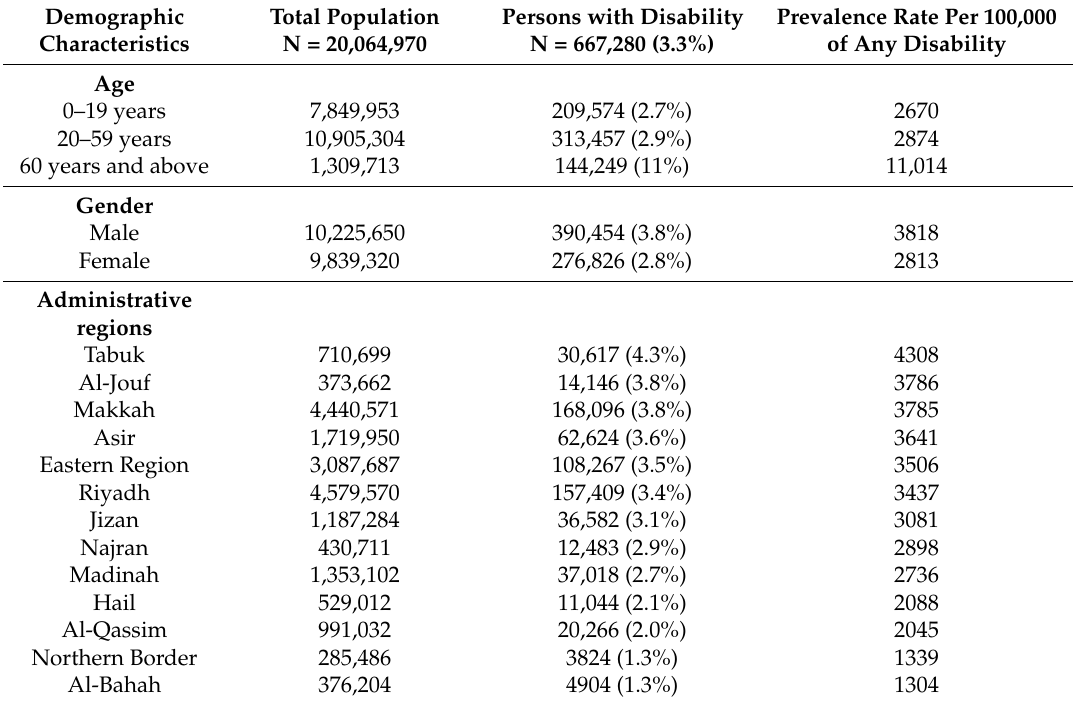
Table 2. Disability prevalence rates in 2016 by basic demographic variables in Saudi